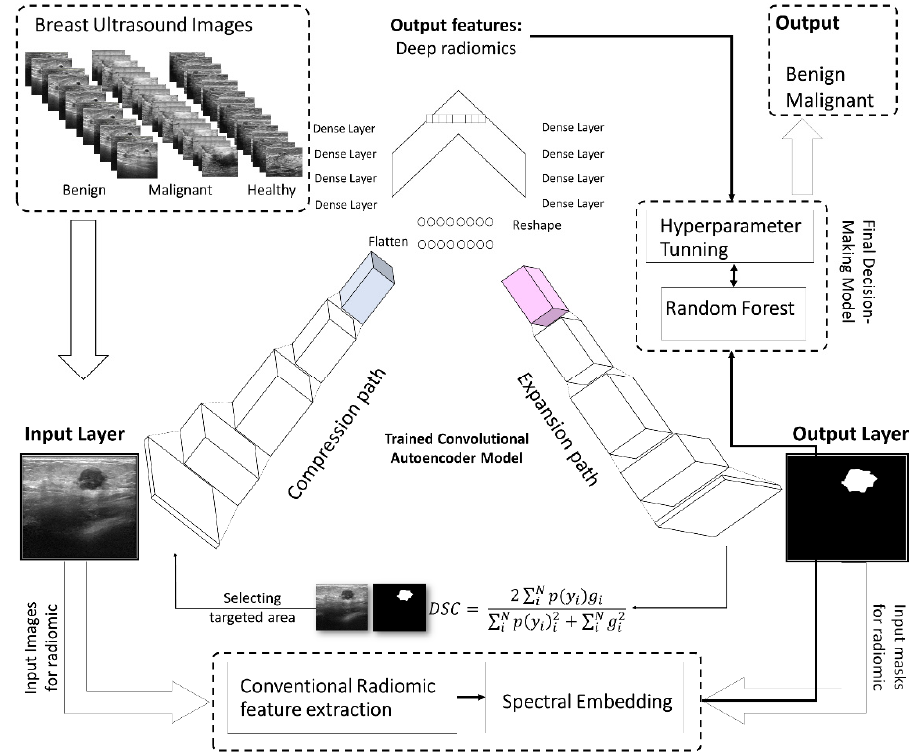
Figure 1. The workflow for automated breast lesion finding and breast cancer diagnostic system using deep autoencoder. The segmentation and radiomic extraction tasks are embedded in a single unit of the deep neural network, which mitigates the amount of data and training time required for the training of the model.